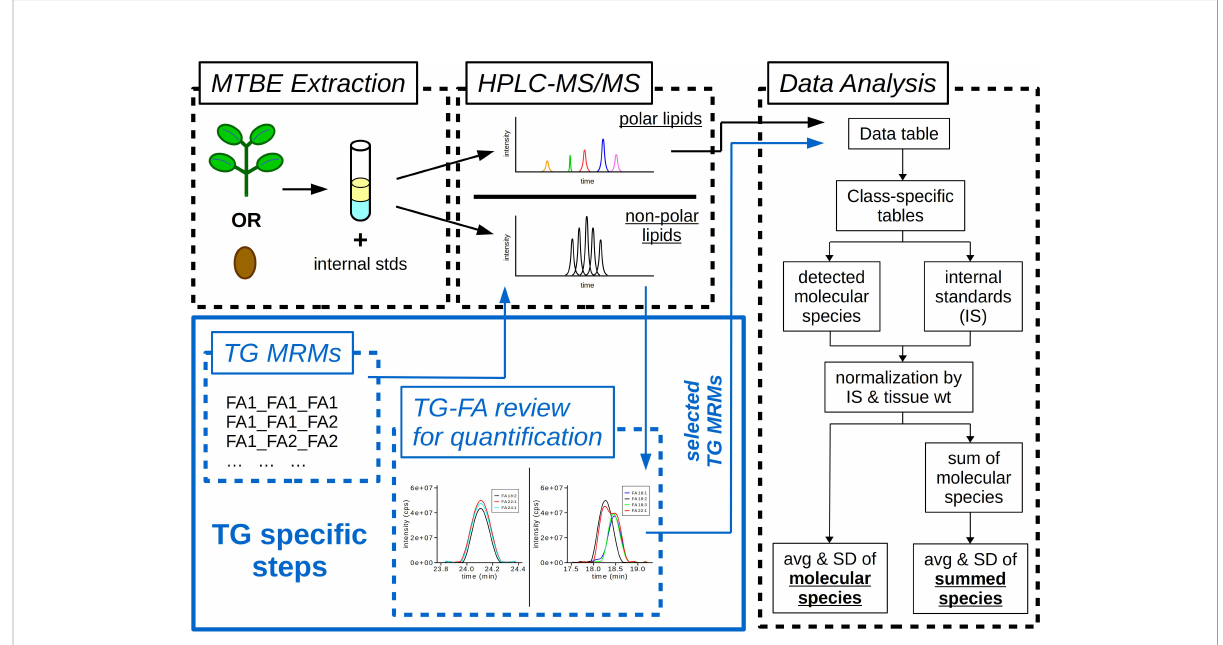
FIGURE 5 Work fl ow of lipidomics methods. Samples (leaf or seed) extracted using a methyl-tert-butyl ether (MTBE) extraction. During extraction samples are spiked with internal standards (IS) containing both polar and non-polar lipids. Final extracts are diluted and resuspended in appropriate solvents for two different HPLC-MS/MS methods, one for polar lipids and the other for non-polar lipids. Analysis of triacylglycerols (TG) requires additional steps to determine fatty acid (FA) composition. TG MRMs are calculated for each potential FA composition. TG-FA extracted ion chromatograms (XIC) are overlaid for each TG molecular species to determine the MRM transitions to use for data analysis and quanti fi cation. Custom R scripts quantify the integrated LC peak areas for each lipid class, then normalize the data by tissue weight (wt) and IS. The fi nal output is the average (avg) and standard deviation (SD) for each molecular species of each lipid class and the avg and SD of the summed lipid